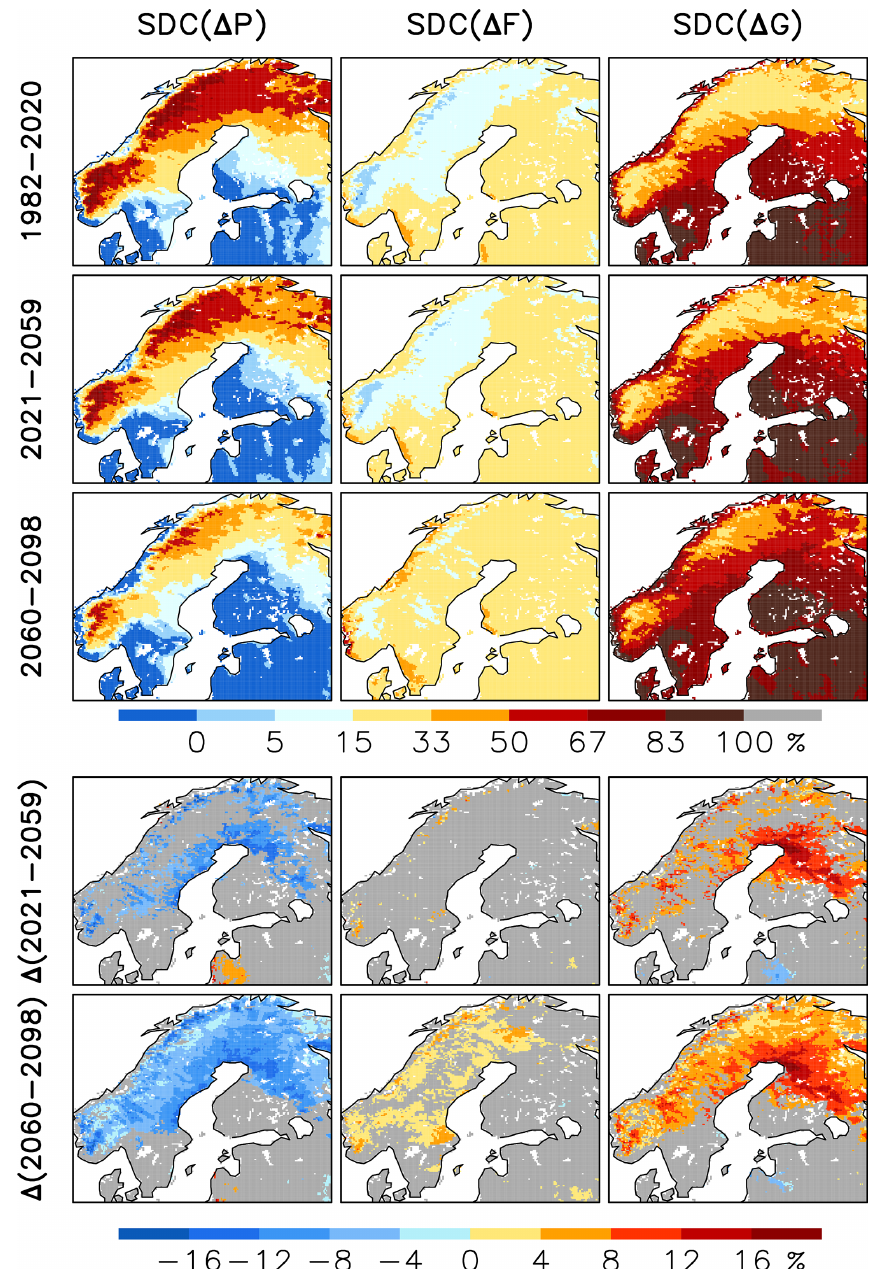
Figure 13. Relative contributions of variations of total precipitation ( (cid:49)P ), the snowfall fraction ( (cid:49)F ) and the snow-on-ground fraction ( (cid:49)G ) to the multi-RCM mean of the standard deviation of the March mean SWE in the EURO-CORDEX simulations. Rows 1–3: the contributions in three 39-year periods separately. Rows 4–5: the changes from 1982–2000 to 2021–2059 and 2060–2098. Grey shading is used in areas in which less than 14 of the 17 RCMs agree on the sign of the